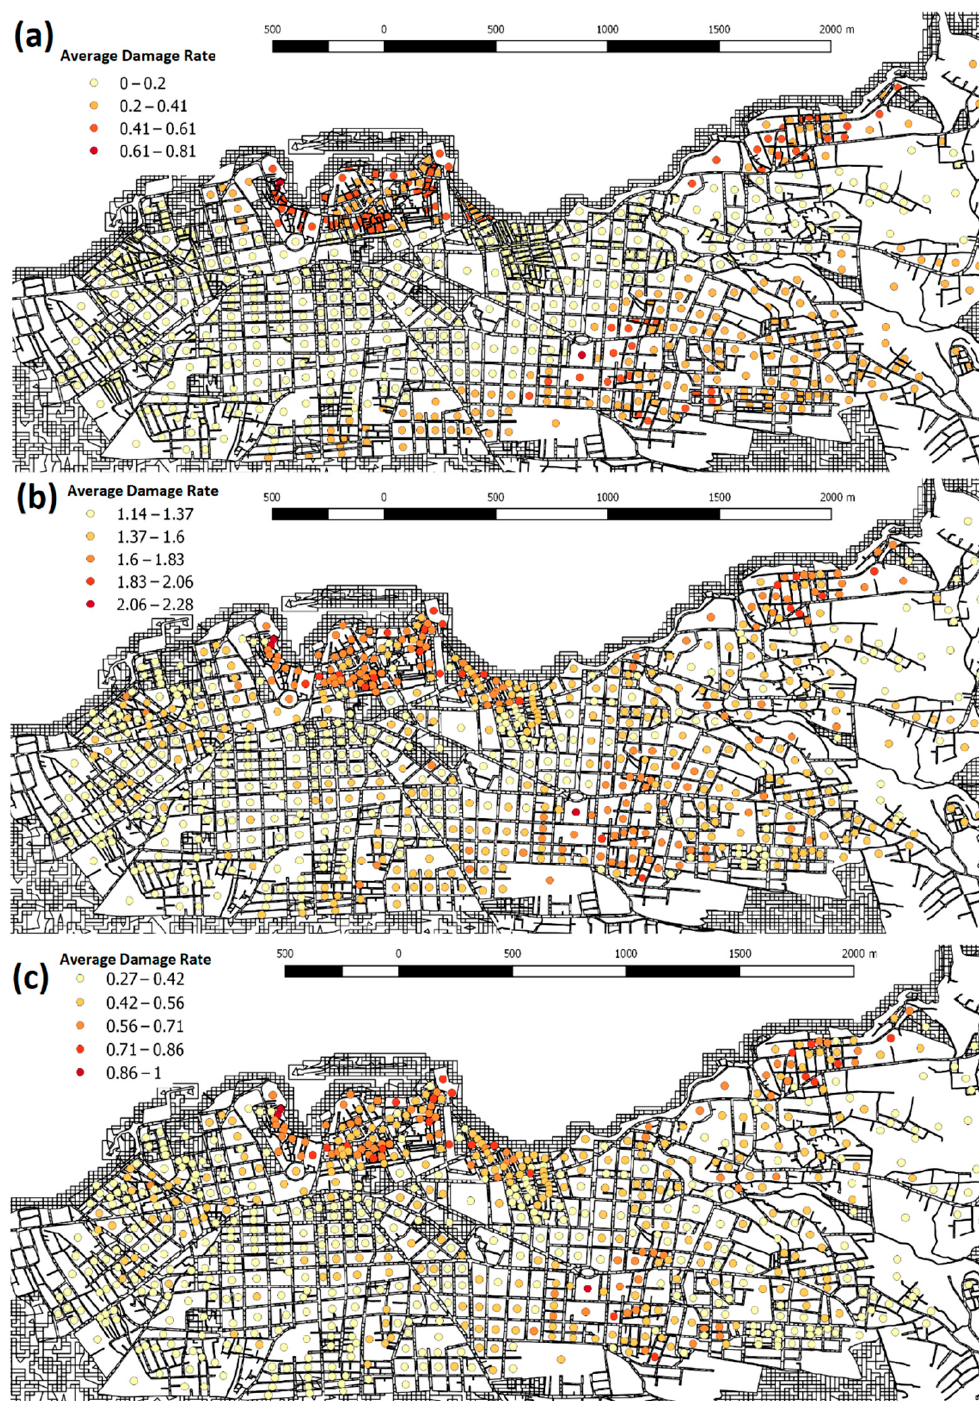
Figure 7. Estimated average damage rates per building block according to the attenuation formulas of ( a ) Ambraseys et al., ( b ) CSO 2003, and ( c ) Sabettaand